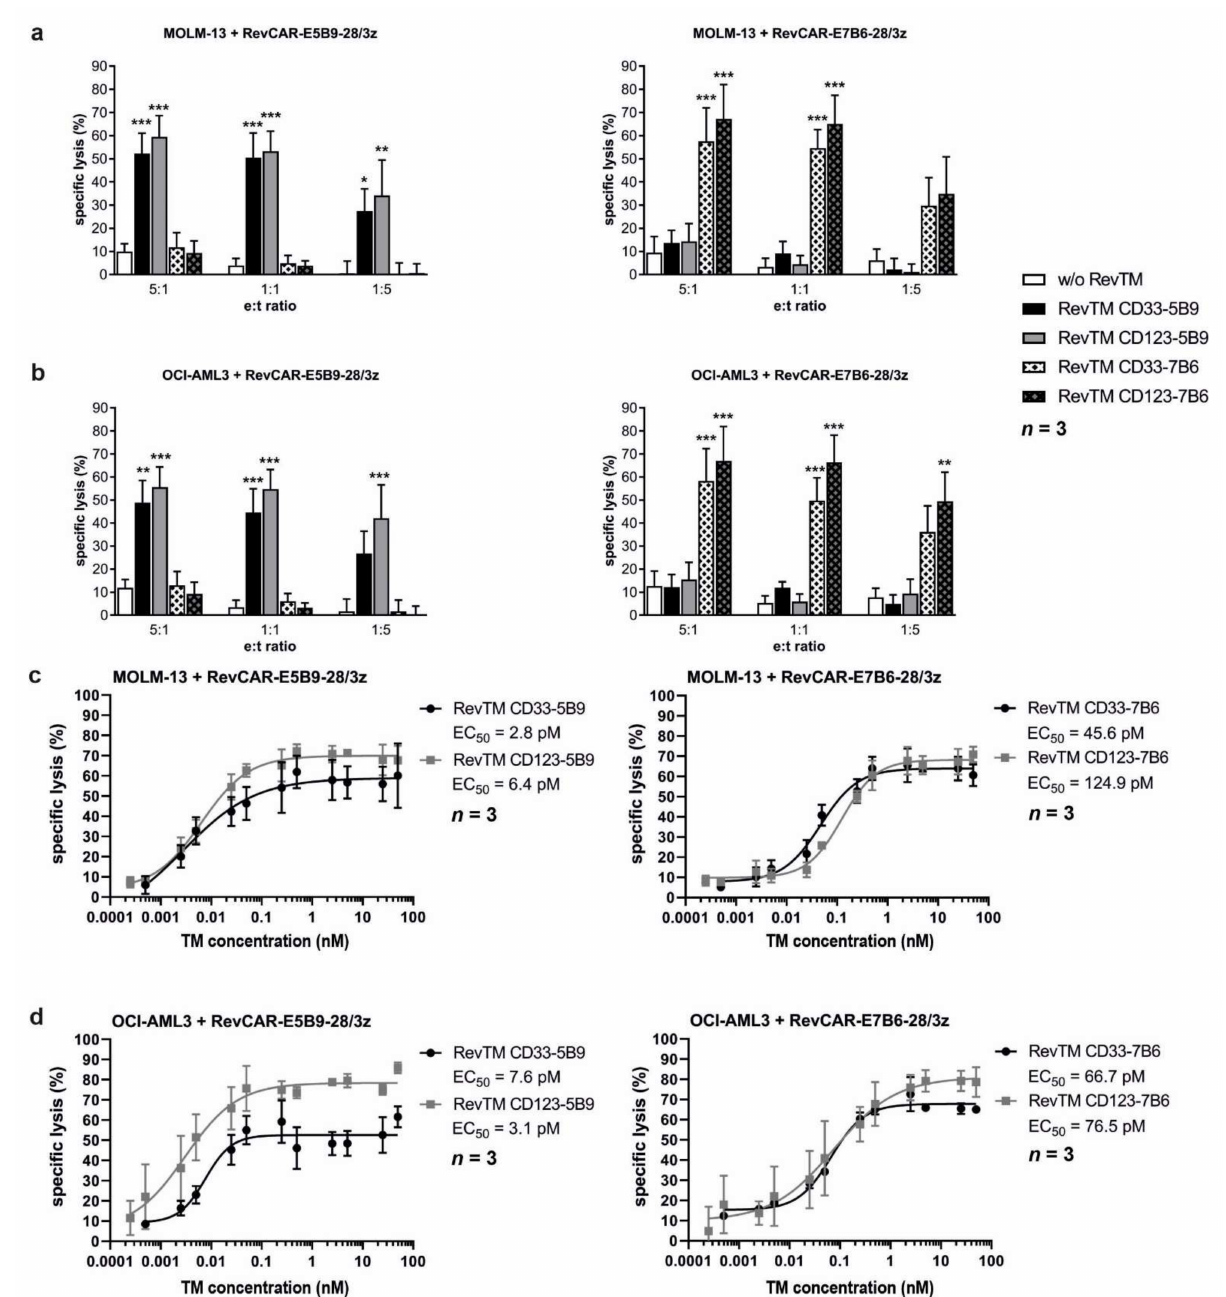
Figure 4. Lysis of AML cell lines by redirected RevCAR T-cells . 51 Cr-labeled ( a , c ) MOLM-13 or ( b , d ) OCI-AML3 cells were incubated with RevCAR-E5B9-28/3z or RevCAR-E7B6-28/3z T-cells at different effector to target cell (e:t) ratios in the presence or absence of indicated RevTMs. ( a , b ) Data are shown for three individual T-cell donors represented as mean ± SEM (Two-way ANOVA with Bonferroni’s multiple comparisons test. Significance was determined as comparison to the setting w/o RevTM.). ( c , d ) Effector and target cells were co-cultured at a ratio of 5:1 in the presence of the indicated RevTMs with increasing concentrations to calculate the half-maximal effective concentration (EC 50 ) values. Data are shown for three individual T-cell donors represented as mean ± SEM. p values below 0.0332 were considered significant: p < 0.0332 (*), p < 0.0021 (**), p < 0.0002